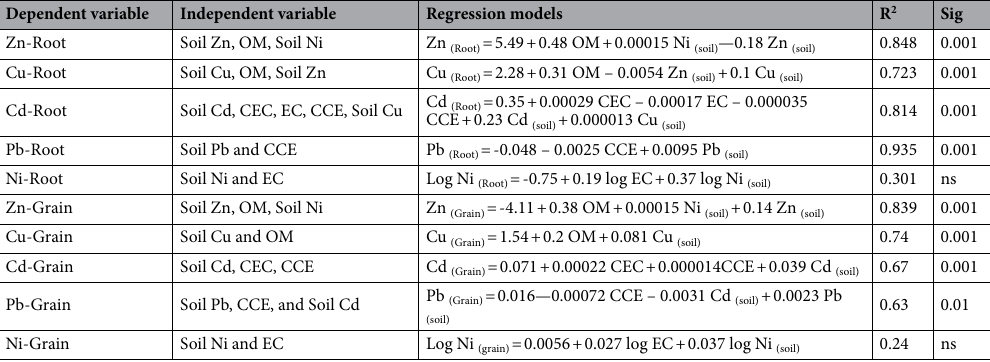
Table 6. Multiple regression models for predicting the concentration of heavy meals in the root and grain of corn.